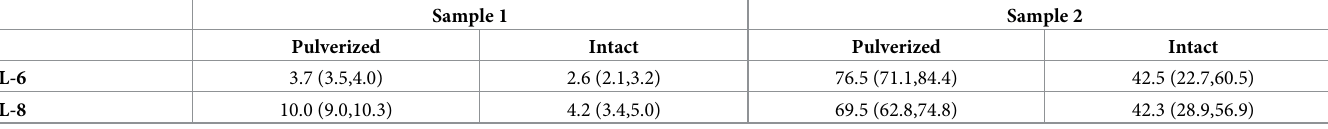
Table 3. Cytokine concentrations with and without mechanical pulverization of tissue prior to homogenization.